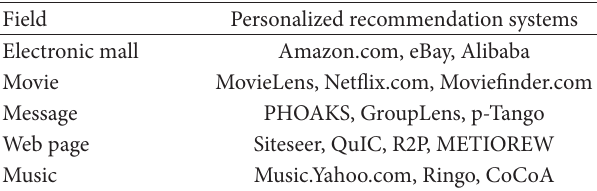
Table 1: The typical recommendation